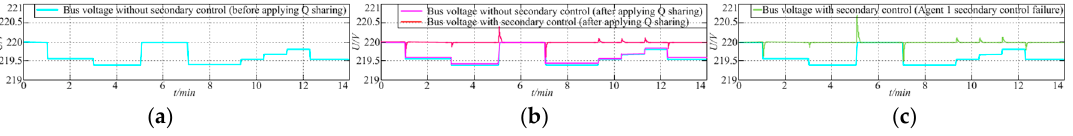
Figure 9. Active power outputs of DGs when secondary control of DG 3 failure. Figure 11. Bus voltage root mean square (RMS) value. ( a ) Before applying Q sharing; ( b ) After applying Q sharing; ( c ) DG 1 secondary control failure. Figure 12. Static and dynamic droop rates between DGs. ( a ) Static droop rate ratio; ( b ) Static and dynamic droop rate ratio.